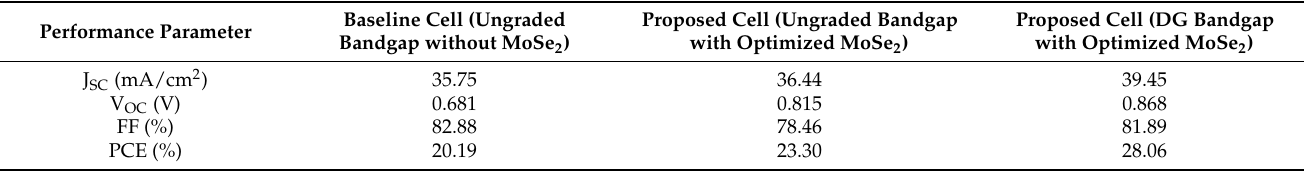
Table 9. Performance Parameters of the Proposed CIGS Cell Structure in Comparison to the Recorded Experimental Cell. Performance